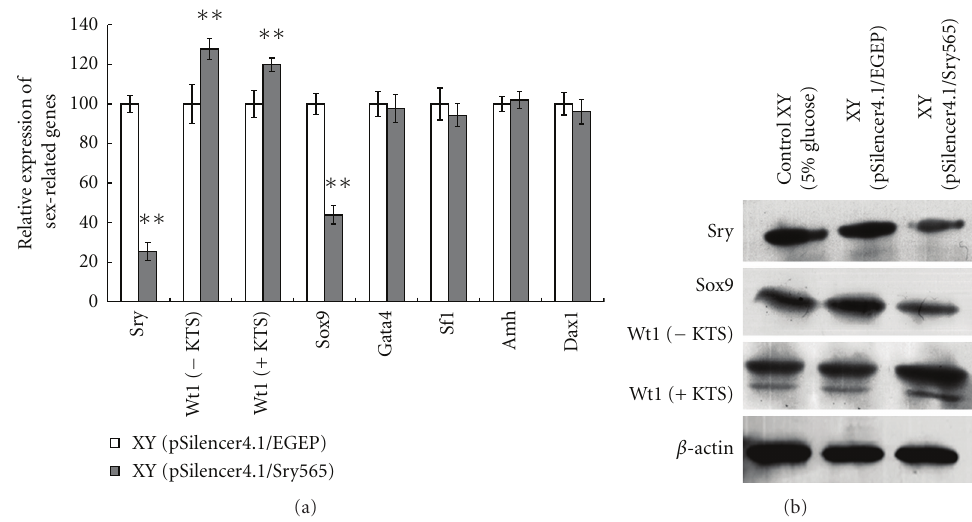
Figure 5: E ff ects of Sry silencing on gene expression in 11.5 dpc male embryo gonads. The value of each gene expression level was divided to the β -actin expression level in Control males and was normalized as 100%. The two-tail t -test was employed to statistically analyze the results: ∗∗ P < 0 .